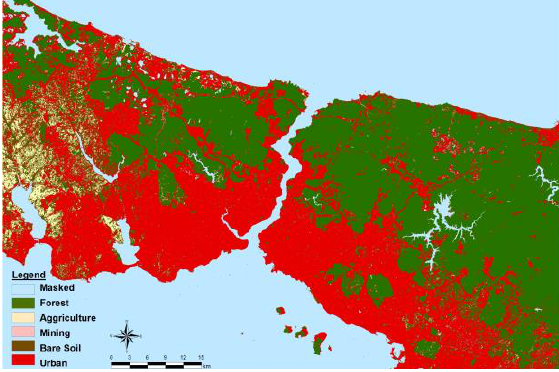
Figure 3: Changes in LULC classes.